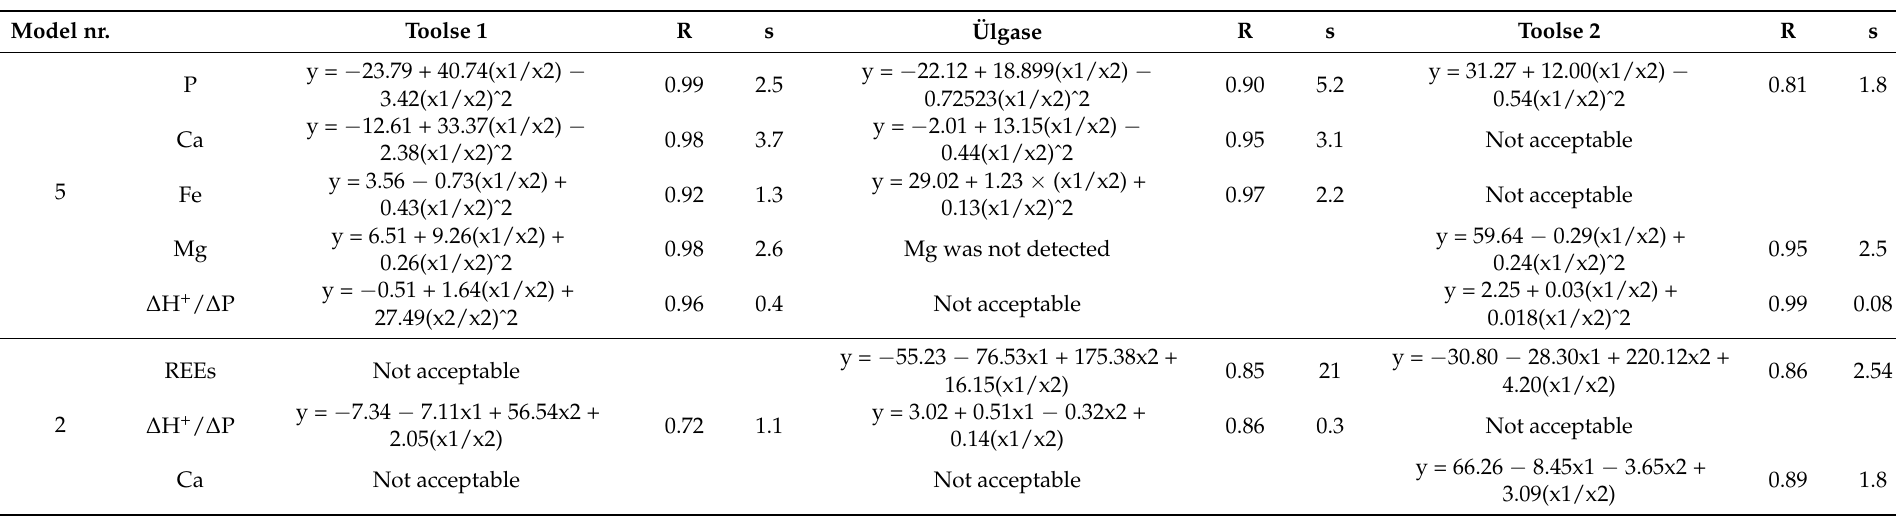
Table 5. The equations with the best squared correlation coefficient (R) and the root mean squared error (s) values for the dissolution of different elements of the studied samples and of ∆ H + / ∆